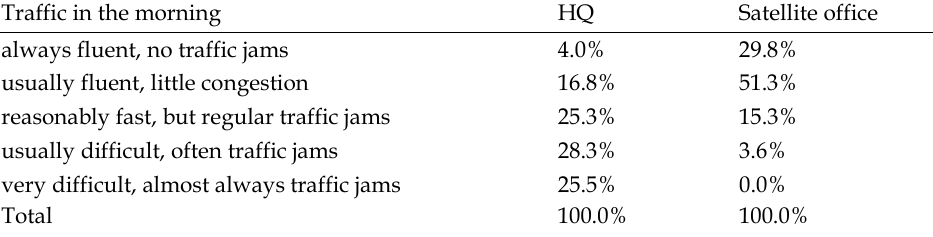
Table 1. Respondents estimation of morning traffic intensity on the way to HQ and satellite office (MOBI, 2012)